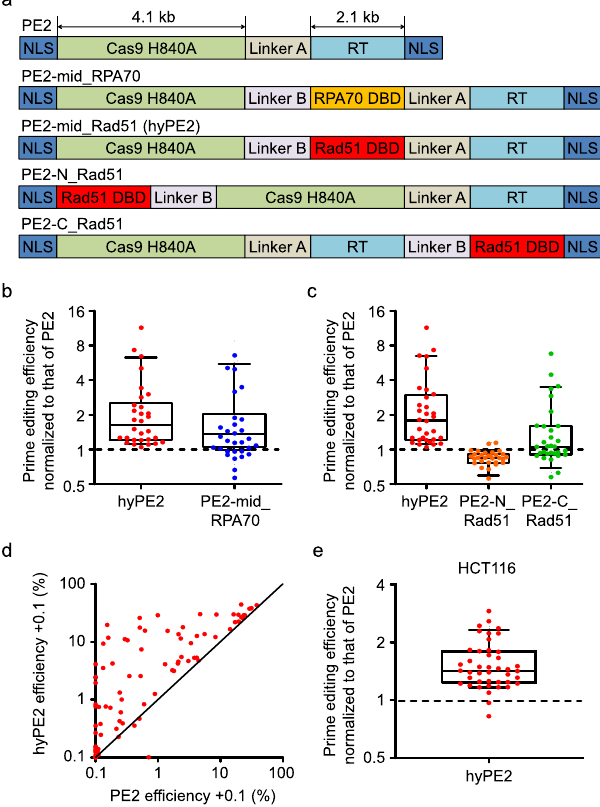
Fig. 1 Design and activity evaluation of PE2 variants containing single- strand DNA-binding domains. a The structure of the PE2 variants containing the single-strand DNA-binding domains (ssDBDs) RPA70 DBD and Rad51 DBD. NLS nuclear-localization signal, RT reverse transcriptase. b , c Prime editing ef fi ciencies of PE2 variants normalized to the ef fi ciency of PE2 at the same target sequences, which had been lentivirally integrated in HEK293T cells. The number of target sequences n = 30 ( b ) and 32 ( c ). d Comparison of the prime-editing ef fi ciencies of PE2 and hyPE2 in HEK293T cells. The black line indicates y = x . The data points represent the average prime-editing ef fi ciency from three biological replicates at each target sequence. In all, 0.1% was added to all ef fi ciency values so that log scales could be used for both the x- and y axes. The number of target sequences n = 88. e Prime editing ef fi ciencies of PE2 variants normalized to the ef fi ciency of PE2 at the same target sequences, which had been lentivirally integrated in HCT116 cells. The number of target sequences n = 43. b , c , e PegRNAs that resulted in PE2-directed prime-editing ef fi ciencies higher than 1% are shown. Data of minimum-to-maximum values are presented. For the boxes, the top, middle, and bottom lines represent the 25th, 50th, and 75th percentiles, respectively. The whiskers indicate the 10th- and 90th-percentile values. Source data are provided as a Source Data fi